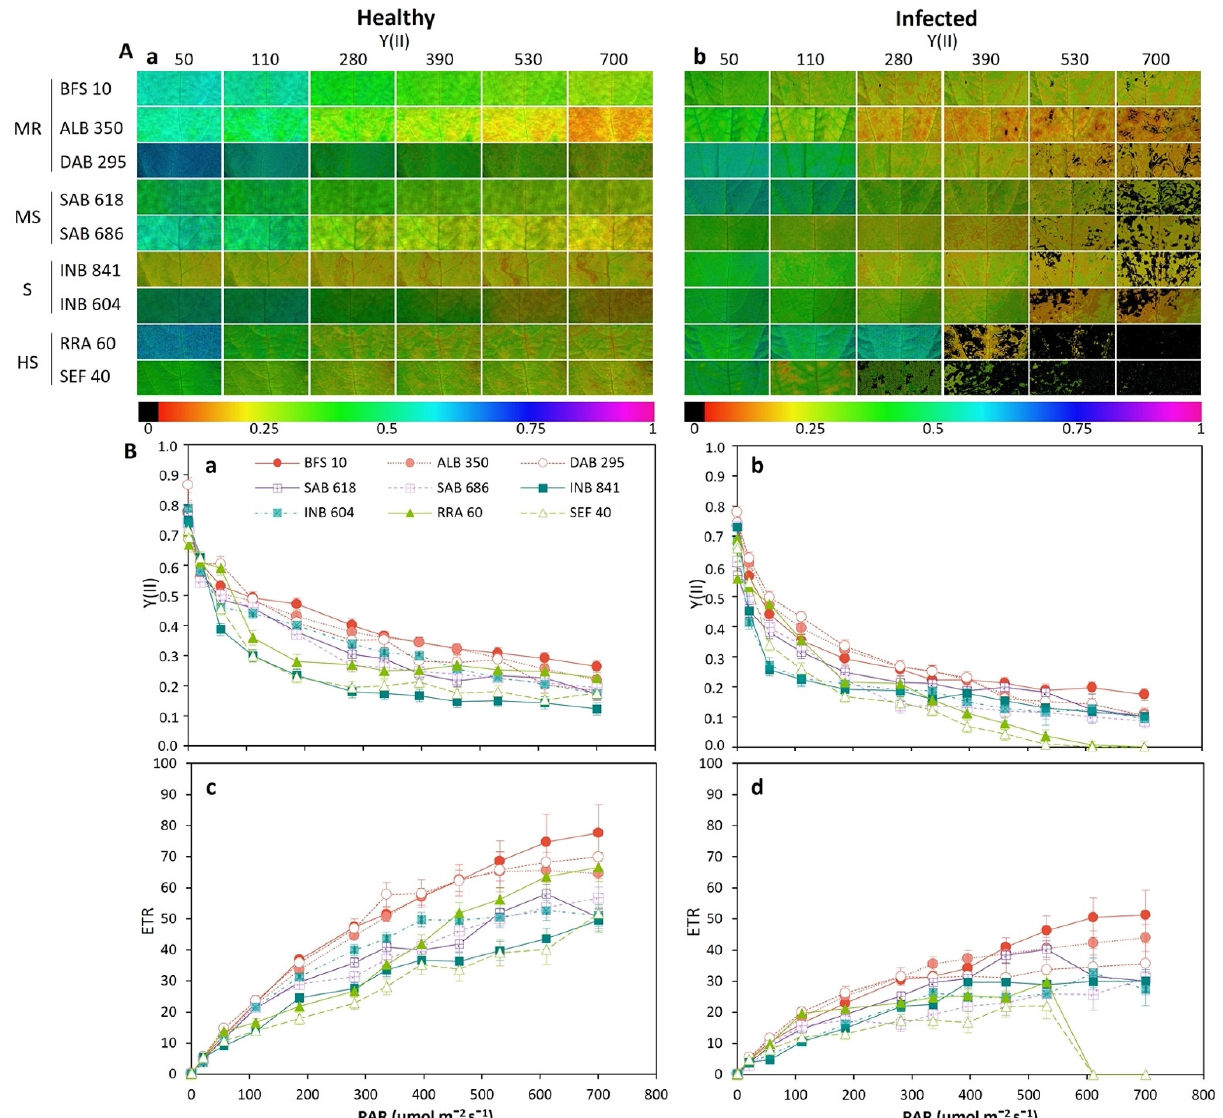
Figure 7. Response to disease stress as a function of the photosynthetically active radiation (PAR) levels of common bean lines conforming to different typologies. BSF 10, ALB 350, DAB 295: moderately resistant (MR). SAB 618, SAB 686: moderately susceptible (MS). INB 841 and INB 604: susceptible (S). RRA 60 and SEF 40: highly susceptible (HS). ( A ) Images of the parameter Y(II) obtained by IMAGINE-PAM; the change in the color gradient from violet to red signifies a change in value from higher to lower for each variable. ( B ) Fast light curves of Y(II) as a function of PAR: ( Ba ) Y(II) in healthy leaves; ( Bb ) Y(II) in infected leaves; ( Bc ) ETR in healthy leaves; ( Bd ) ETR in infected leaves. Means and error bars correspond to 96 AOIs (areas of interest) for each condition (healthy and infected); i.e., six AOIs were taken for each leaf, among four plant leaves selected between the fifth and eighth trifoliate leaves (from apex to base) at the beginning of physiological maturity, from four plants of each advanced line of common bean.